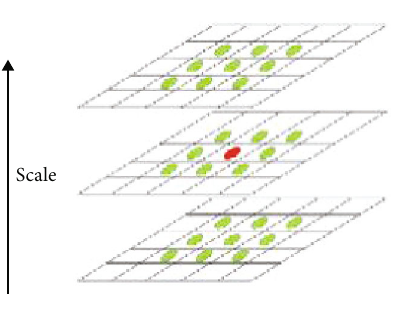
Figure 3: Feature point